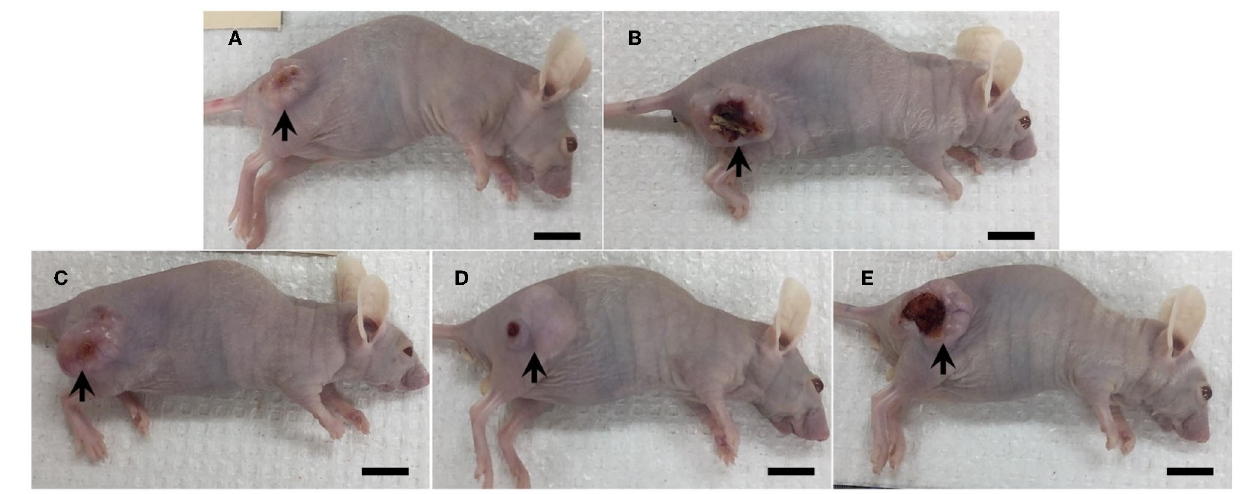
(2.56 ± 0.712) and the treatment groups (2.60 ± 0.681, 2.40 ± 0.770, and 2.60 ± 0.507 for 1, 5, and 10 mg/kg BW THC:CBD, respectively) was significantly lower than in the negative